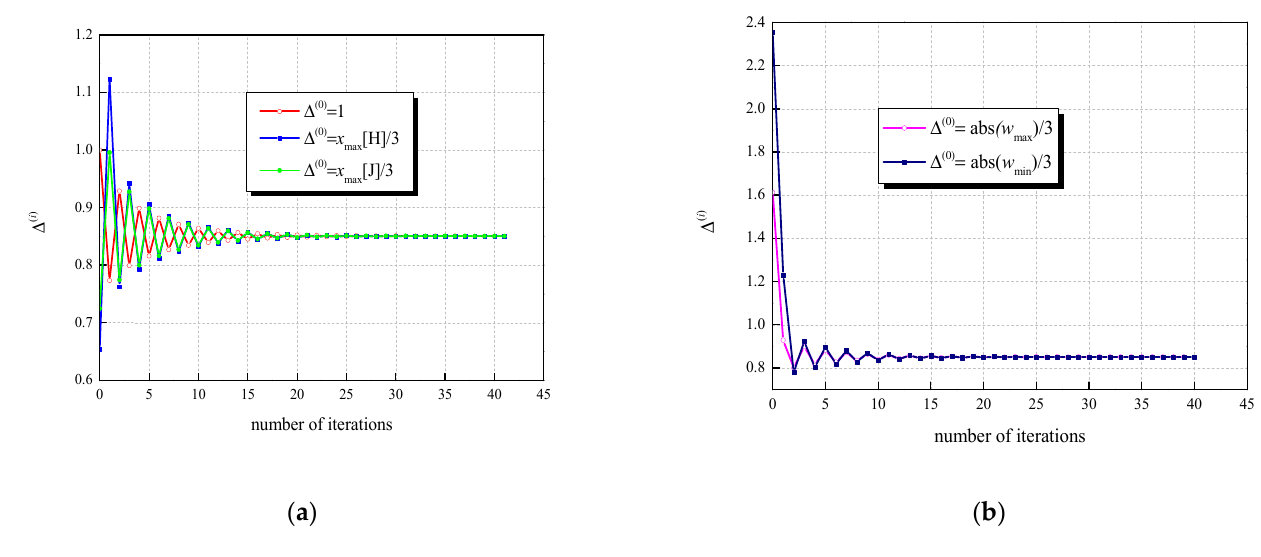
Figure 5. Algorithm convergence ilustration: ( a ) Δ (0) = 1, Δ (0) = x max [H]/3, Δ (0) = x max [J] /3; ( b ) Δ (0) = | w max |/3, Δ (0) = | w min |/3.